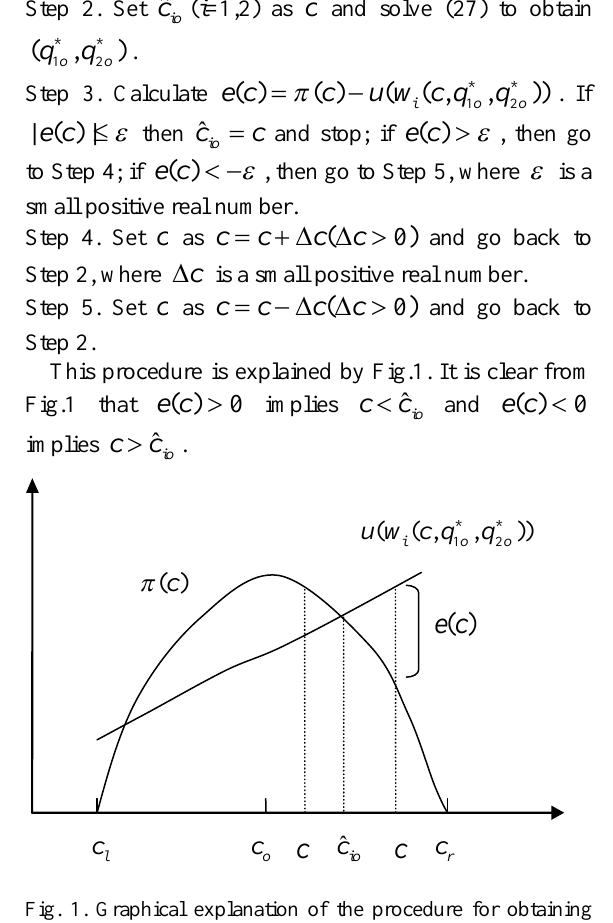
Fig. 1. Graphical explanation of the procedure for obtaining c ˆ . io